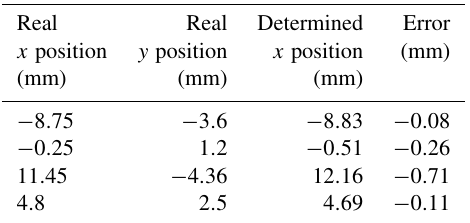
Table 2. Four measurements at random positions to determine the x